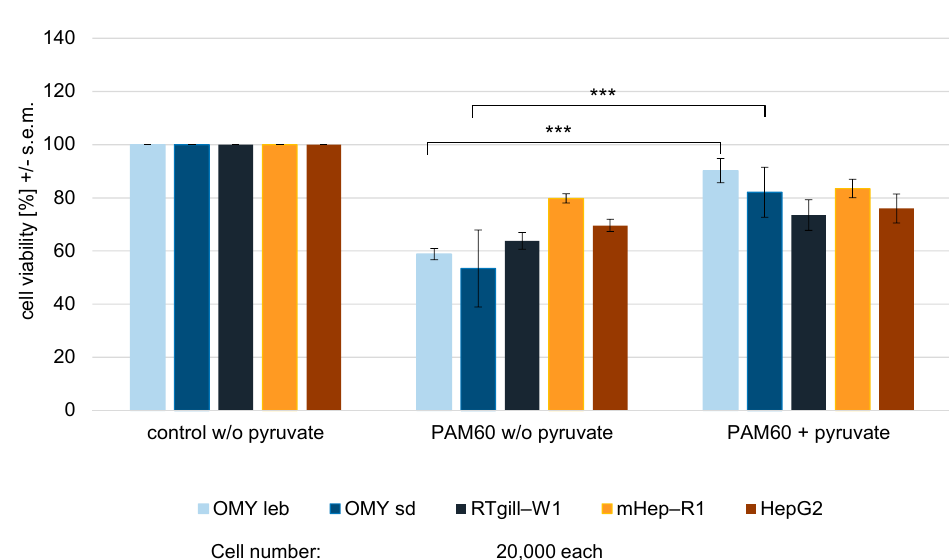
Figure 7. Cell viability of plasma-treated cells cultured in DMEM without pyruvate compared with DMEM with pyruvate (1 mM). Fish cells OMYleb and OMYsd react much more sensitively to PAM without pyruvate, while the other cell lines are less affected ( n = 3).